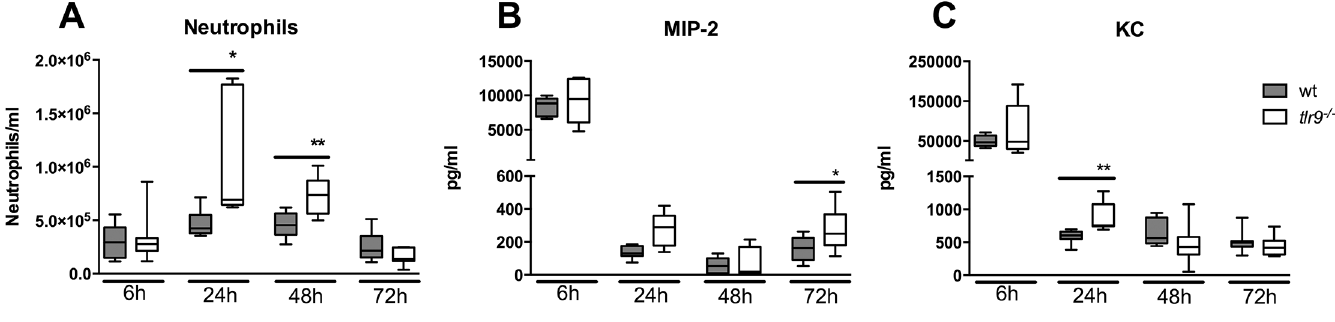
Figure 4 . Enhanced neutrophil influx into the alveolar space of tlr9 –/– mice during S . aureus pneumonia. Wt (gray) and tlr9 –/– mice (white) were infected with 1 × 10 7 MRSA bacteria via intranasal inoculation and euthanized at the indicated time points thereafter. (A) Neutro- phils, (B) MIP-2 and (C) KC in BALF are expressed as box-and-whisker diagrams depicting the median, the smallest observation, lower quartile, median, upper quartile and largest observation ( n = 8 mice per group at each time point). * p < 0.05, ** p < 0.01 versus Wt mice at the same time